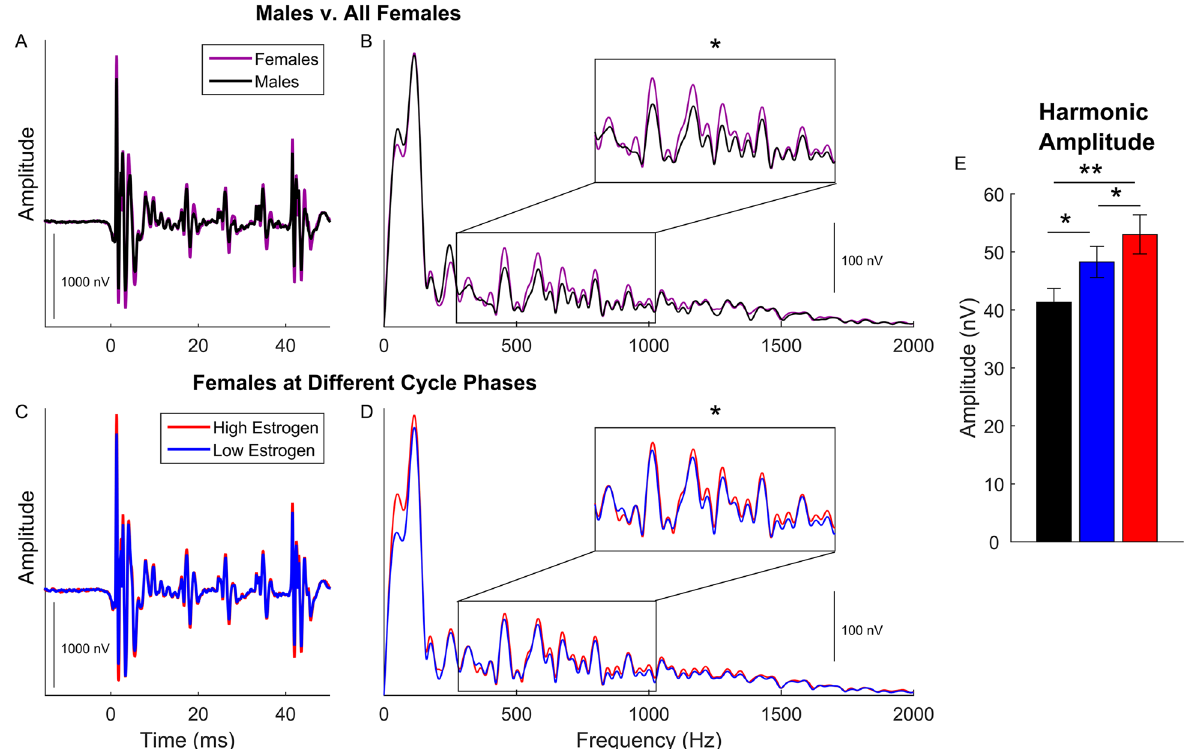
Figure 1. Time and frequency plots show harmonic encoding differences between male and female rats and variation in harmonic encoding across the female estrous cycle. Males (black) are plotted against all females (purple) in the time ( A ) and frequency ( B ) domains. The inset in B illustrates the frequency range of the harmonic analysis. This difference is specific to harmonic frequencies; no differences are seen in response to the fundamental frequency (75–160 Hz). In the bottom plots, within-subject comparisons of female responses are plotted in the time ( C ) and frequency ( D ) domains separately for recordings during proestrus/estrus (red), when estrogen levels were high, and during diestrus/metestrus (blue), when estrogen levels were low. The bar graph ( E ) plots the average ± 1 standard error harmonic amplitude for males (black), diestrus/metestrus females (blue), and proestrus/estrus females (red).